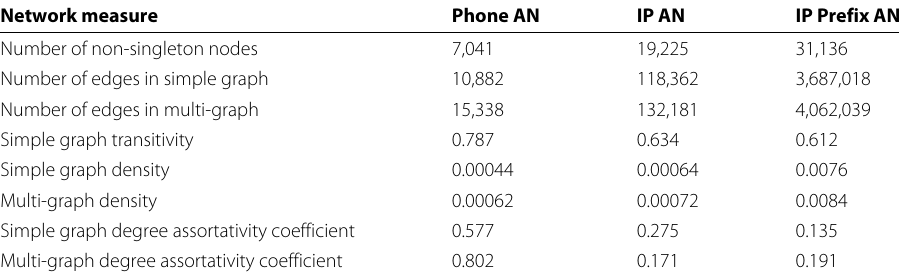
Table 1 Network measures on the three different kinds of activity networks (ANs) of which the constructions were previously described. Density, and other such metrics, were computed with respect to non-singleton nodes e.g., the density of the simple graph underlying the phone activity network is 10,882/(7041*7040/2) which is approximately 0.00044 (as reported)